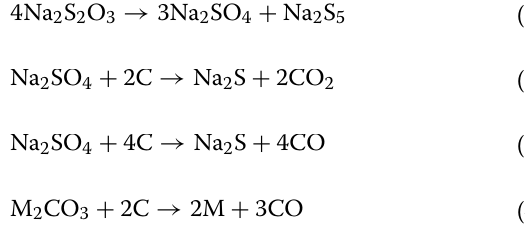
As depicted in Additional file 1: Table S1 and Fig. 2, the surface area, pore volume and pore diameter distribution of all catalysts were calculated by the N 2 adsorption– desorption isotherms. All the isotherms were attributed to the typical hybrid-type-IV isotherm suggesting the involvement of micropores and mesopores. All the hys- teresis loops were H 4 -type, and there was no evident saturation adsorption platform, verifying that the pore structure was consisted of anomalous pores (Fig.